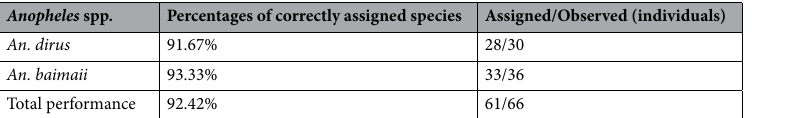
Table 4. Cross-validated scores based on the wing shapes of Anopheles dirus and An. baimaii .